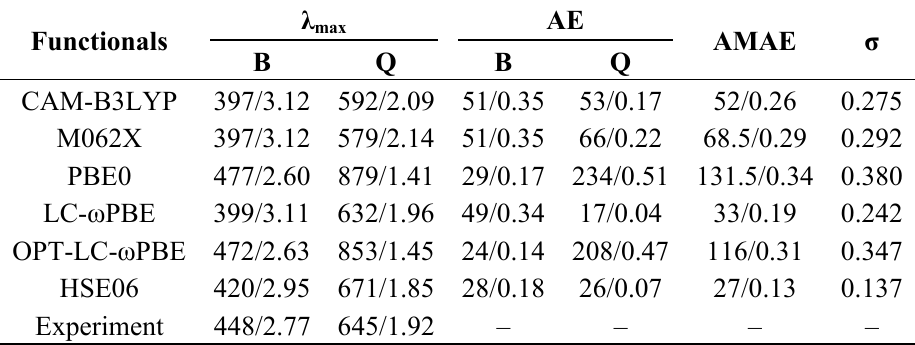
Table 2. The calculated absorption λ (nm/eV) and the absolute errors (AE, in nm/eV) of max B and Q bands for YD2-o-C8 with different functionals in TDDFT, the arithmetic mean absolute errors (AMAE, in nm/eV) and mean square error σ (in eV) are also listed. Functionals